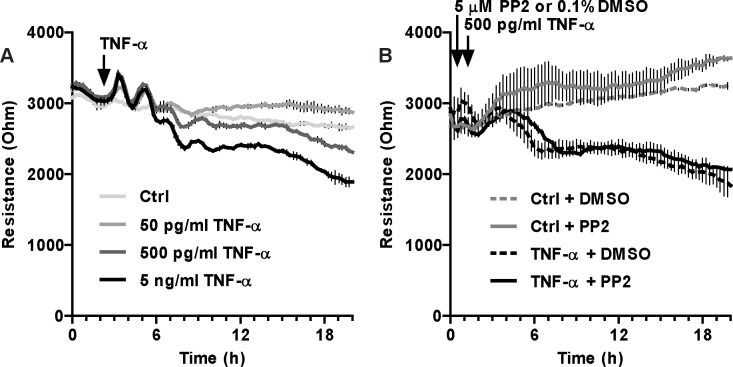
TNF-α-dependent loss of monolayer resistance in HDMEC does not depend on SFK activity.A, Three days after cells were seeded at confluence on 8W10E ECIS electrodes, complete growth media was replaced by EBM-2 containing 0.3% FBS and incubated for another 16 hours. Then, cells were treated with different amounts of TNF-α (as shown). TEER at 4 kHz was measured every 5 minutes for at least 20 hours post-treatment. B, Cells were treated as in A, except cells were pretreated with either DMSO (vehicle) or PP2 (SFK inhibitor) for 30 minutes prior to TNF-α addition. Notice the lack of response to TNF-α doses of 50 pg/ml or below as well as the inability of PP2 to prevent the loss of barrier function induced by a high TNF-α dose. Results are representative of at least three independent experiments performed in duplicate. Bar graphs with data presented as mean±SEM and statistical analysis of TEER for the 20 h time point are shown in S6A and S6B Fig.